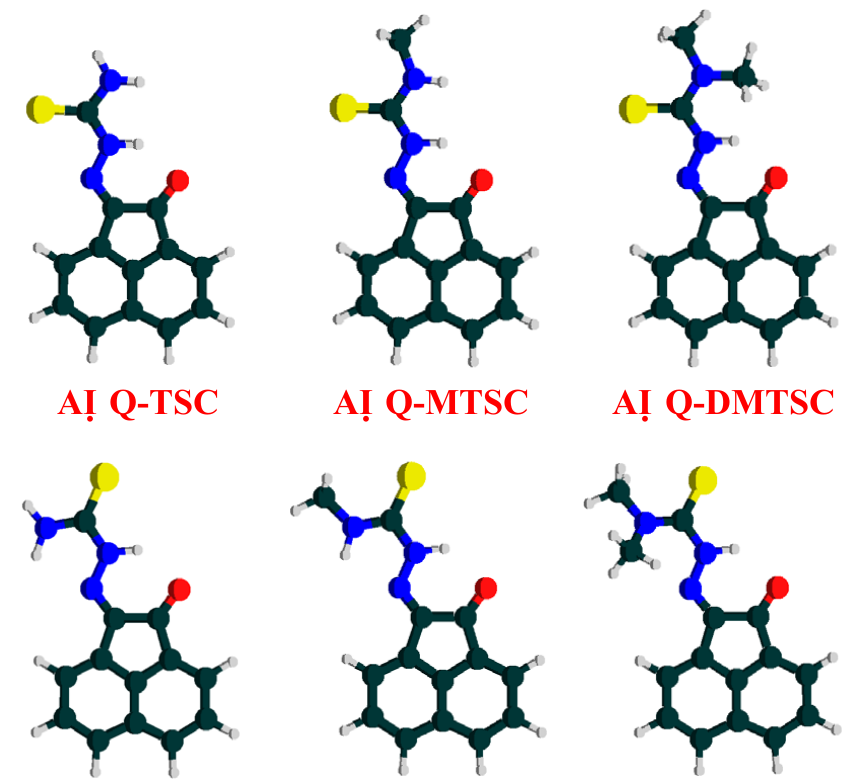
Fig. 1 Optimized structures of acenaphthenequinone-based thiosemicarbazones.